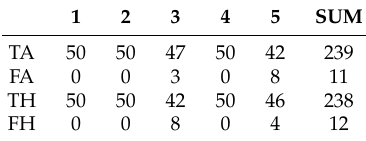
Figure 16. Accuracy of Q1, Q2, Q. Table 8. Results of five test experiments.